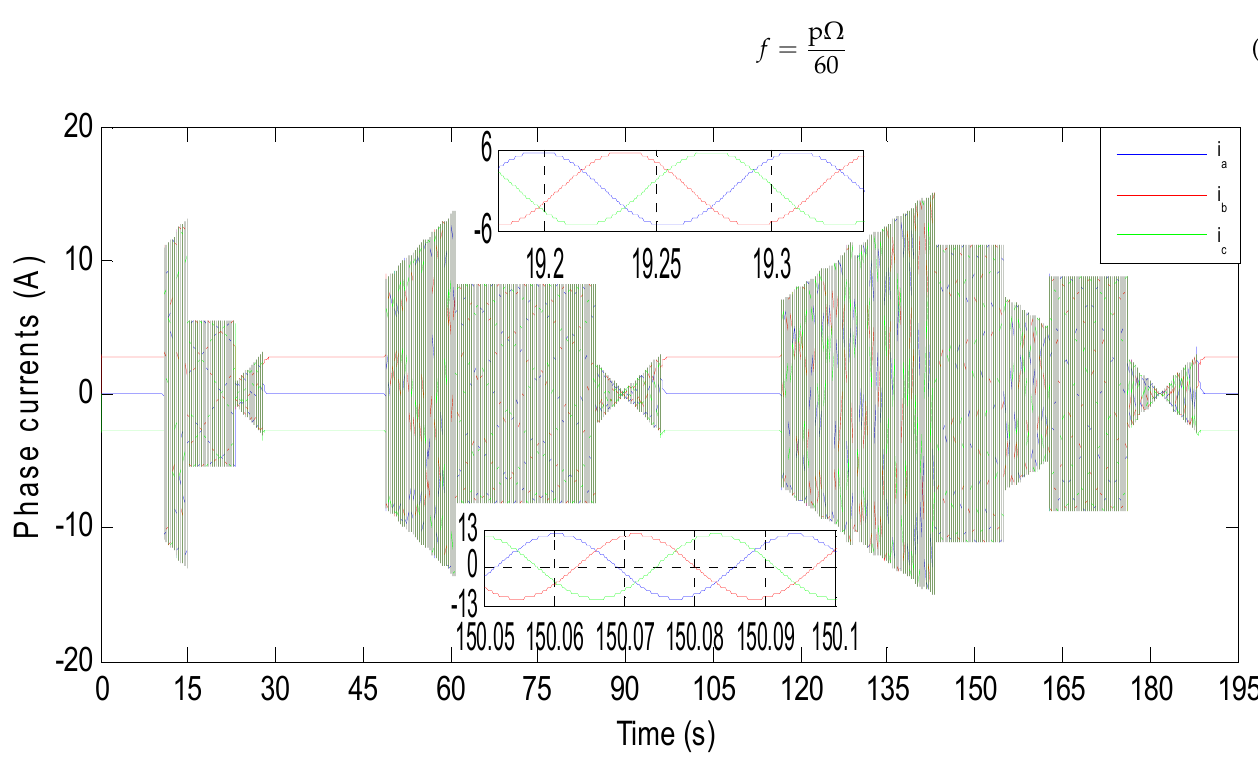
Figure 29. BEV torque response and its reference for ECE driving cycle. When t (cid:15) [96 s, 117 s] in Figure 25, the BEV speed or rotor speed is null. According to Equation (43), this means that the f = 0 Hz, which means that the PMSM currents must be constant at that time interval. Indeed, in Figure 29, PMSM phase currents are constant at that time interval, and their sum is null, which means that there is no current flowing to the motor because the vehicle is at